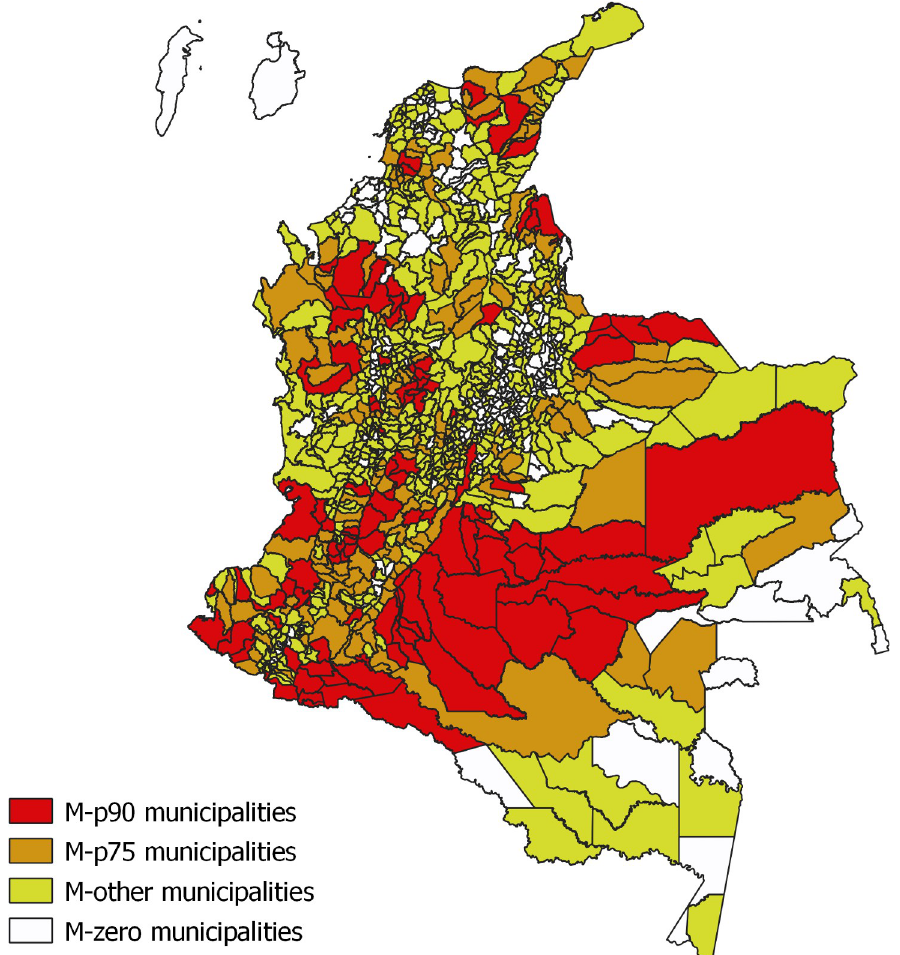
Fig 1. Distribution of categories of municipalities in Colombia according to FARC presence between 2000 and 2017. Classification of Colombian municipalities according to the distribution of the total number of conflict events involving FARC for the years 2000 through to 2017. Four categories of municipalities: (1) M-p90: municipalities with total number of FARC-related violent events above the 90th percentile of the distribution of these events (red); (2) M- p75: municipalities with total number of FARC-related events above the 75th percentile (orange); (3) M-zero: municipalities with no conflict event recorded during the entire 2000–2017 period (whether involving FARC or not) (white); and (4) M-other: municipalities that did not belong to any of the other 3 municipality groups (yellow). FARC, Fuerzas Armadas Revolucionarias de Colombia. Base layer of the map from Geoportal DANE (https://geoportal.dane. gov.co/servicios/descarga-y-metadatos/descarga-mgn-marco-geoestadistico-nacional/).